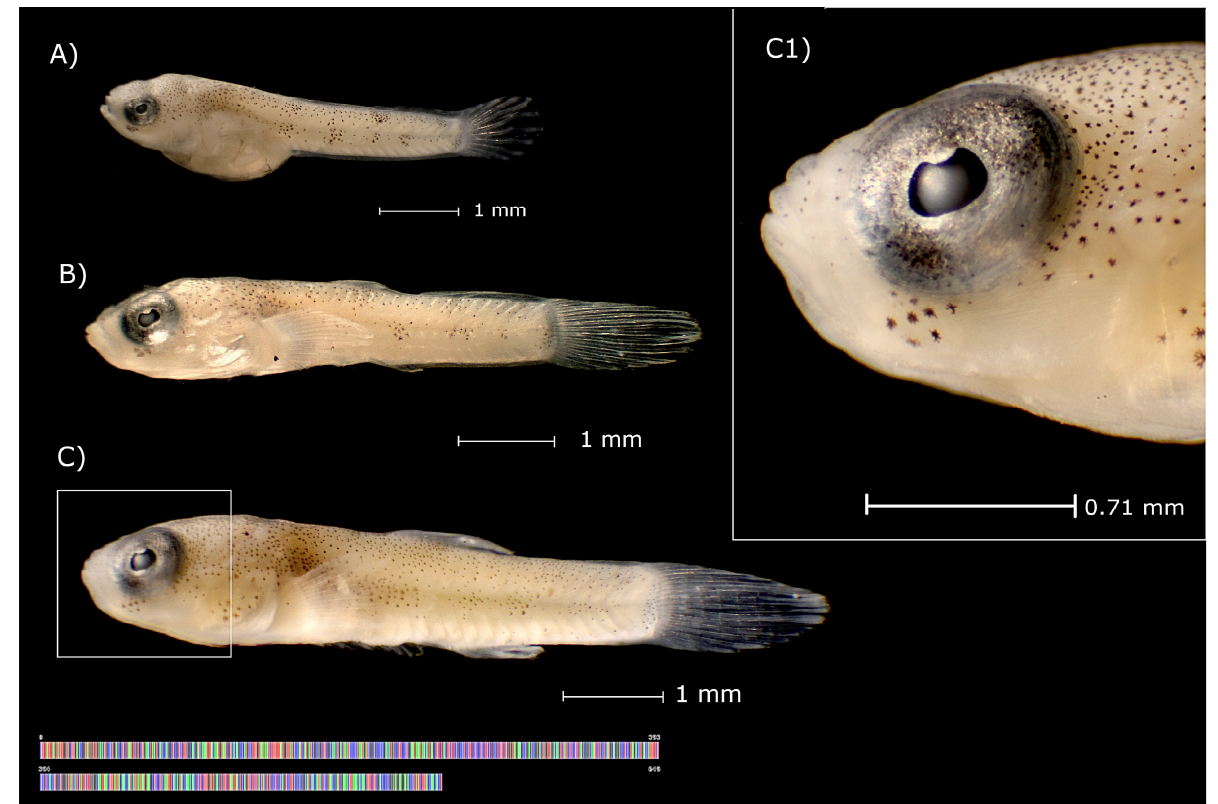
Figure 4. Early stages of development of Floridichthys polyommus with their DNA barcode. ( A ) LT = 5.4 mm; ( B ) LT = 6.4 mm; ( C ) LT = 7.5 mm. ( C1 ) Pigments below the eye, invagination, and pupil